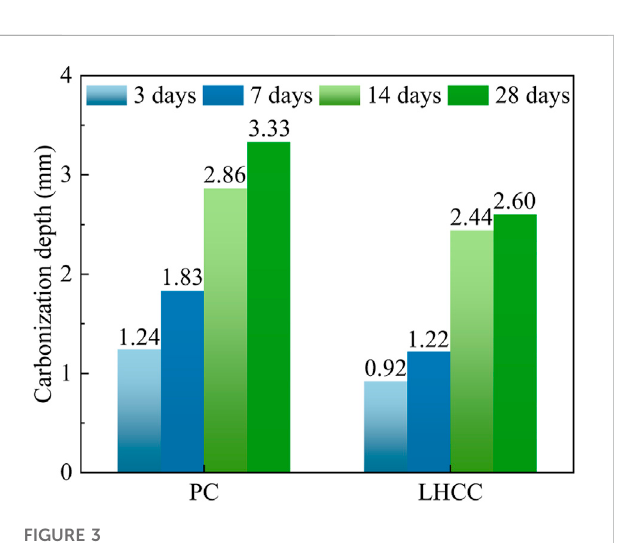
FIGURE 3 Carbonation depths of PC and